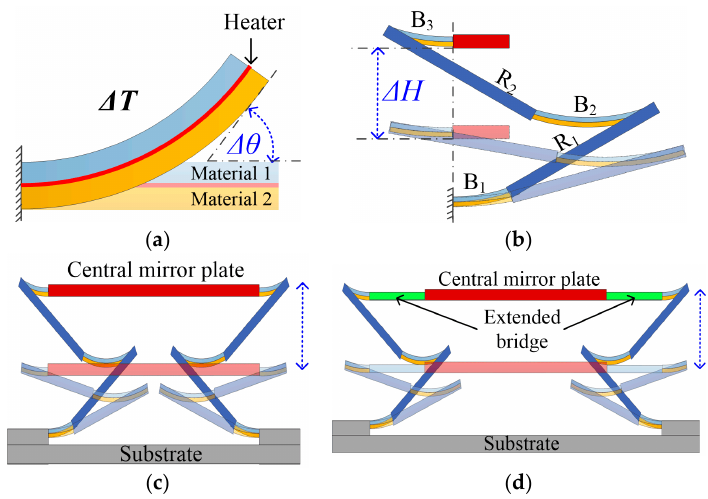
Figure 2. MEMS mirror design: ( a ) The bimorph structure; ( b ) The LSF actuator; ( c ) The basic schematic of LSF MEMS; ( d ) The LSF MEMS with extended bridge.